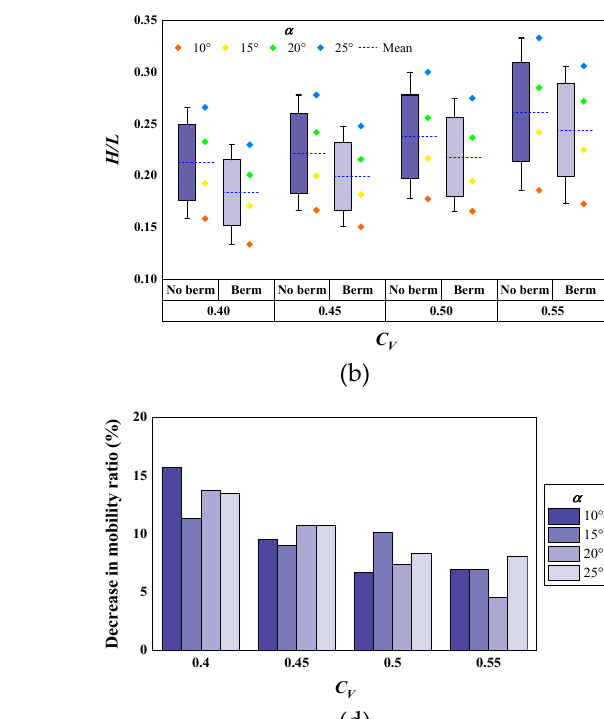
(j) Figure 9. ( a ) μ according to α (at C V = 0.40–0.55); ( b ) μ according to C V (at α = 10°–25°); ( c ) ξ according to α (at C V = 0.40– 0.55); ( d ) ξ according to C V (at α = 10°–25°); ( e ) n according to α (at C V = 0.40–0.55); ( f ) n according to C V (at α = 10°–25°); ( g ) C 1 according to α (at C V = 0.40–0.55); ( h ) C 1 according to C V (at α = 10°–25°); ( i ) C 2 according to α (at C V = 0.40–0.55); ( j ) C 2 according to C V (at α = 10°–25°). 4.1.5. Mobility Ratio Figure 10 shows the debris flow mobility ratio observed through the flume experi- ments and the percent decrease in mobility ratio due to the installation of the berm. Figure 10a,b show the debris flow mobility ratio according to α and C V , respectively. Figure 10c,d show the percent decrease in the debris flow mobility ratio according to α and C V , respec- tively, when the berm was installed. The experimental results confirmed that the debris flow mobility ratio increased as α or C V increased (Figure 10a,b). In the case of the straight channel test, the incremental increases in the mobility ratio due to the increase in α were similar when C V was less than 0.55, but larger when it was 0.55 or greater. The incremental increases in mobility ratio due to the increase in C V were similar when α was 15° or greater, but considerably smaller when it was less than 15°. In the single-berm channel test, the incremental increases in the mobility ratio due to the increase in α were similar when C V was less than 0.55, but larger when it was 0.55 or higher. The incremental increases in mobility ratio due to the increase in C V were similar when α was 20° or greater, but rela- tively smaller when it was less than 20°. In addition, the debris flow mobility ratio was